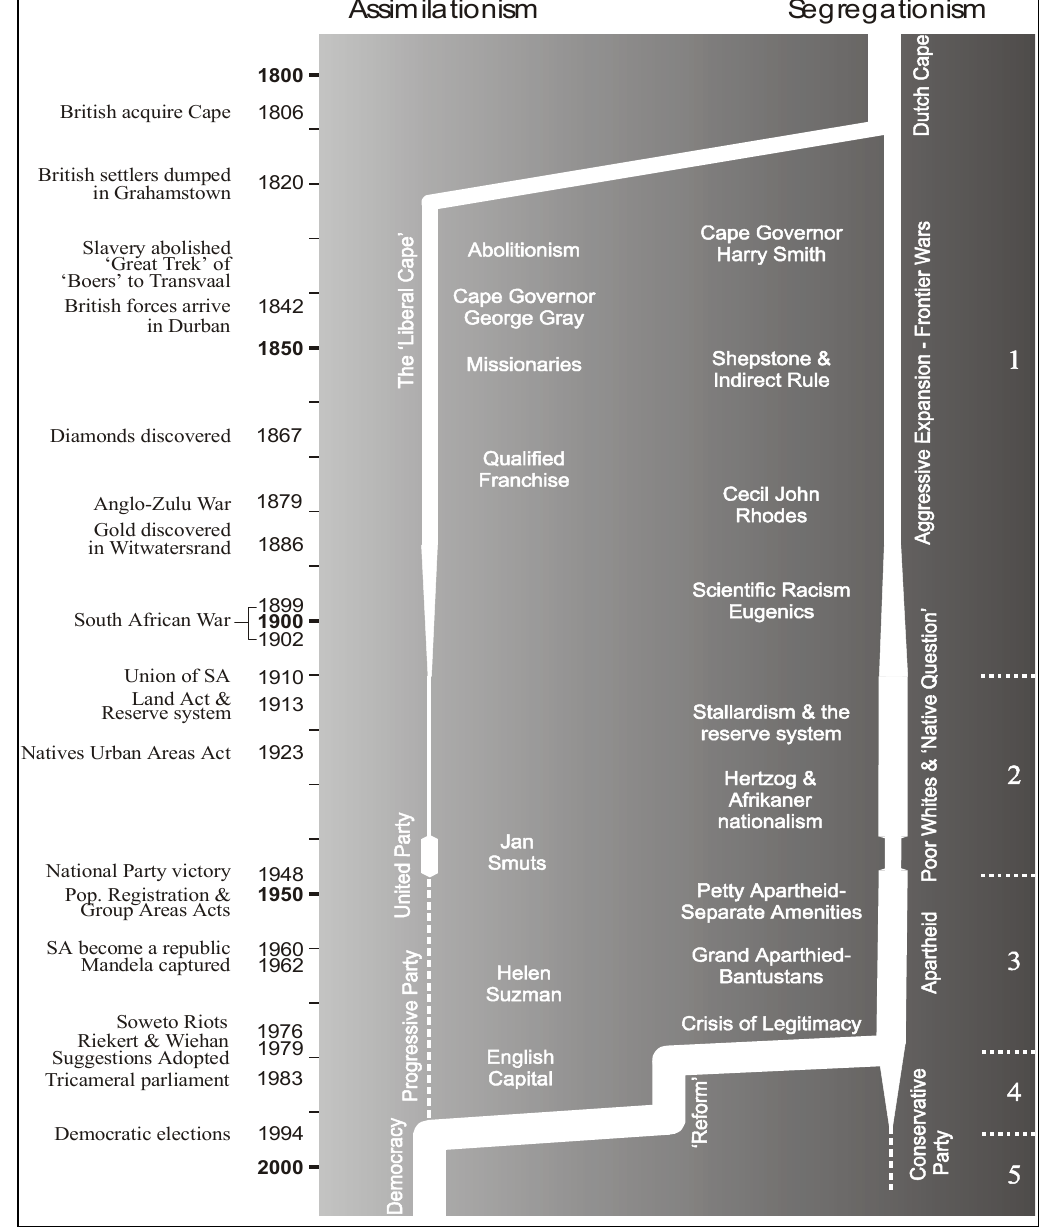
Figure 1: White hegemonic approaches to race